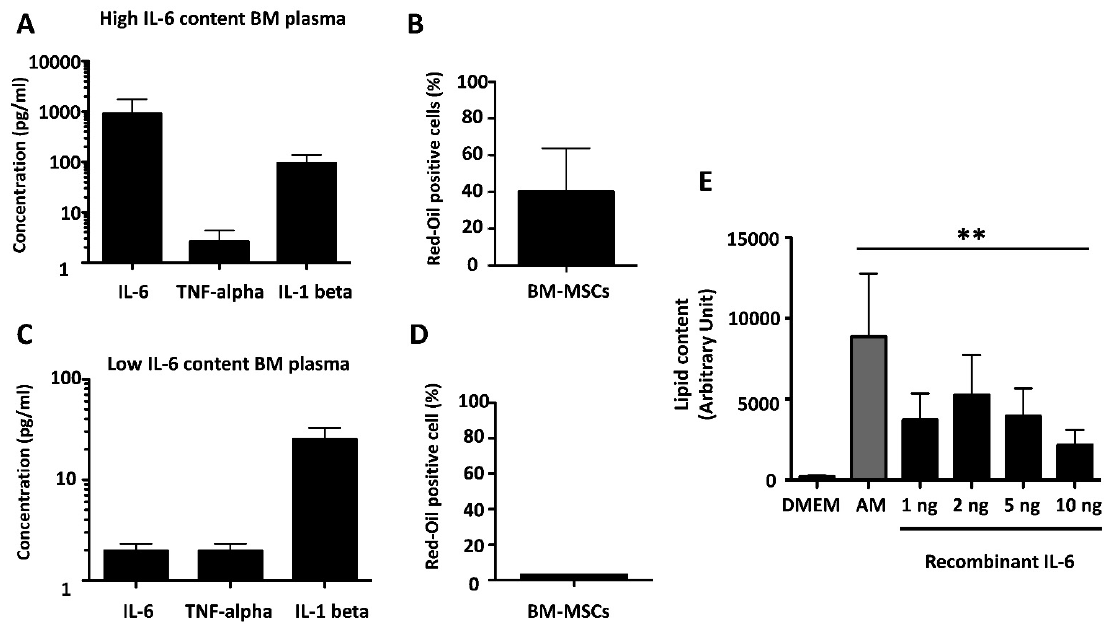
Figure 5. Adipogenesis induced by IL-6-containing BM plasma or by recombinant IL-6. ( A ). IL-6, TNF-alpha, and IL-1 beta concentration in BM plasma assayed in ( B ). ( B ). Percentage of red-oil-positive cells in MSCs treated with four independent “high IL-6 producer” BM plasmas. ( C ). IL-6, TNF-alpha, and IL-1 beta concentration in BM plasma assayed in ( D ). ( D ). Percentage of red-oil-positive cells in MSCs treated with four independent “low IL-6 producers” BM plasmas. ( E ). Lipid content of BM-MSCs upon treatment with recombinant IL-6 at the indicated doses, expressed as mean ± SD of results of pixel densitometry. ** p < 0.01.